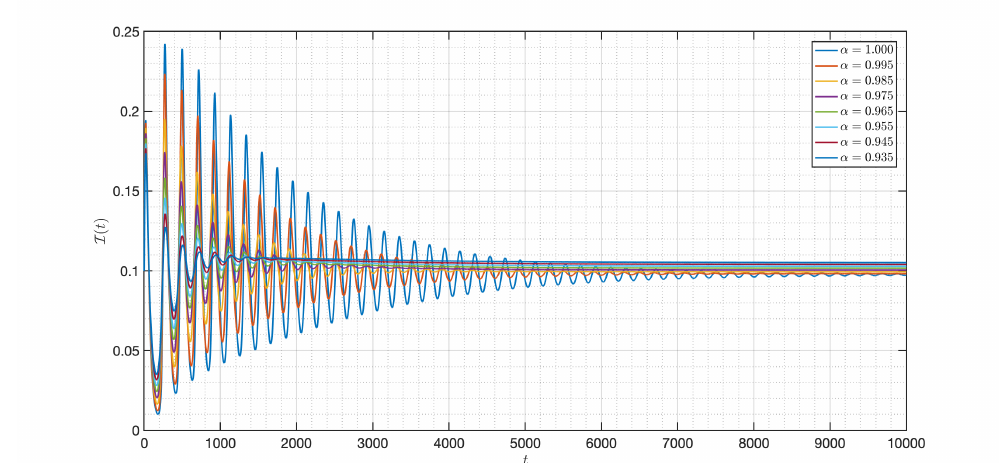
Figure 15. Dynamic of I ( t ) of the model (3) for different parameters in Case II .